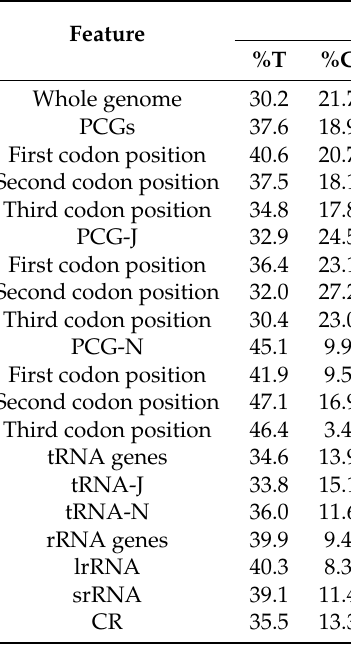
Table 3. The nucleotide composition of the S. teleckojensis